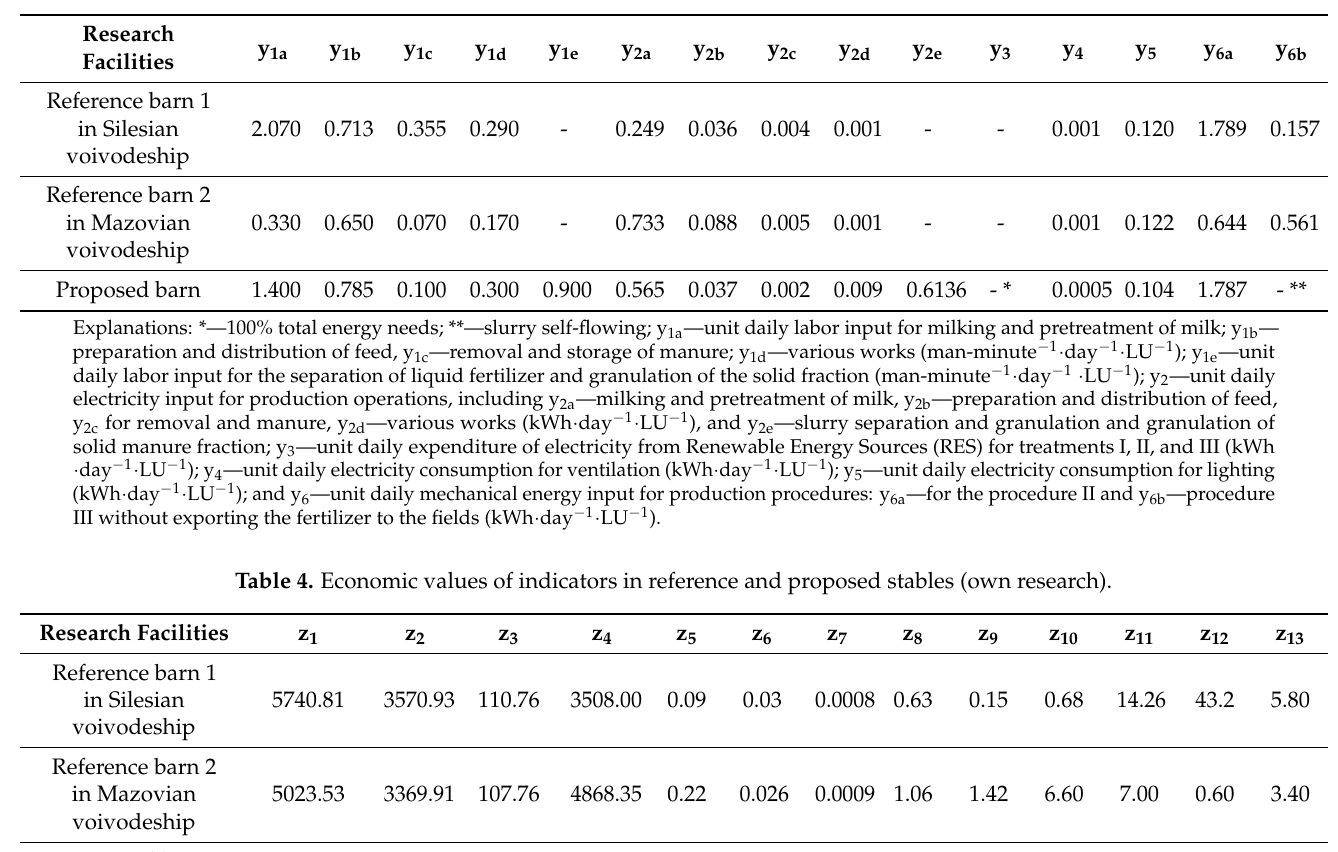
Table 3. Values of technological indicators of the studied objects and the proposed barn (own research).